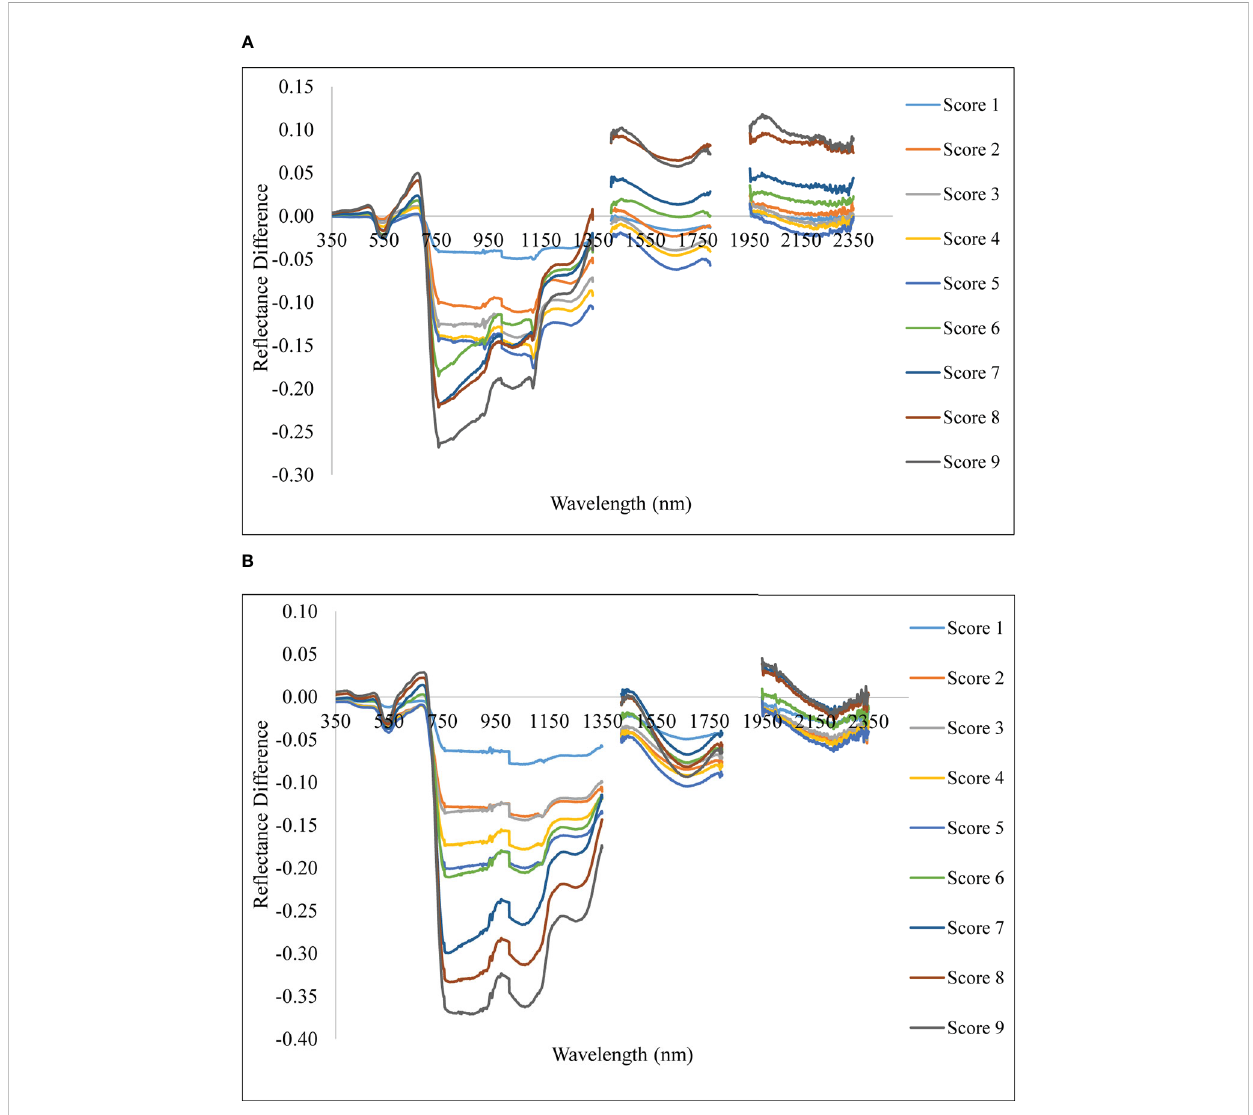
FIGURE 5 Spectral re fl ectance difference of rice plant with different severity levels with reference to healthy. (A) Upland and (B) lowland